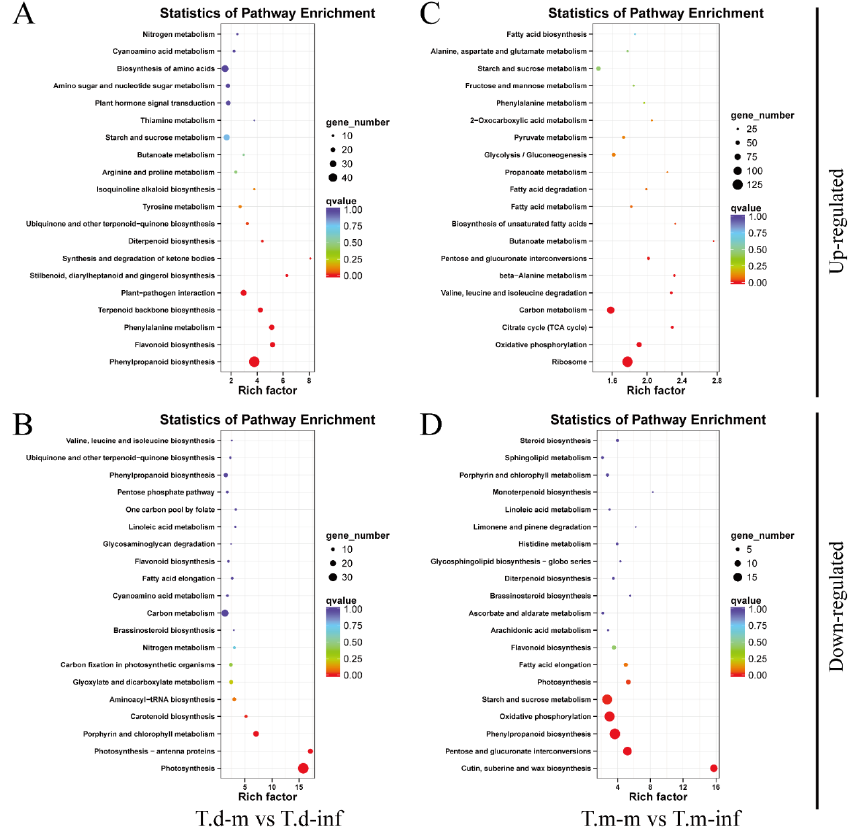
Figure 5. Scatter plot of KEGG pathway enrichment of DEGs. ( A , B ) KEGG pathways based on up-/downregulated DEGs in the T.d-m vs. T.d-inf comparison, respectively. ( C , D ) KEGG pathways based on up-/downregulated DEGs in the T.m-m vs. T.m-inf comparison, respectively. The color of the dots represents the range of the Q-value, and the size of the dots represents the number of DEGs.